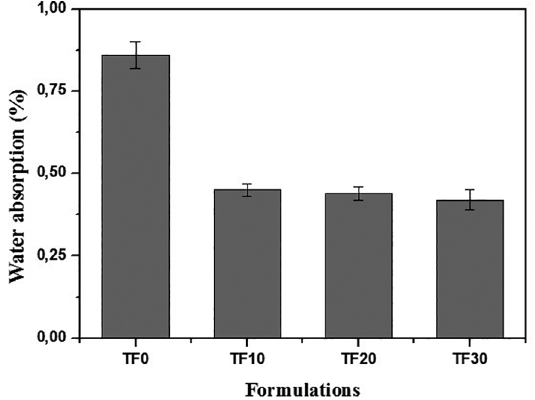
Figure 6. Water absorption of the fired aluminous porcelain pieces.